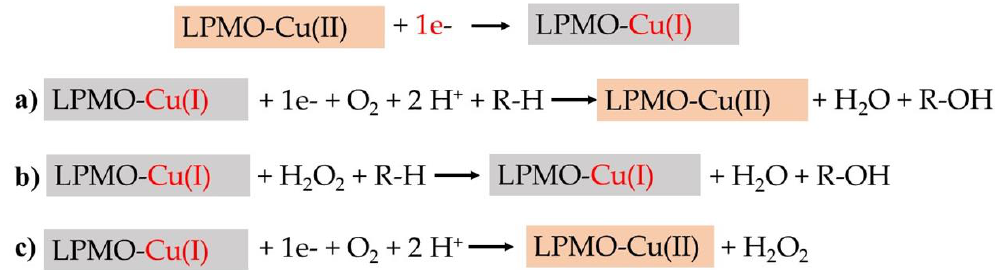
Figure 6. LPMO reaction mechanism. The first step is the reduction of the Cu(II) in the catalytic center by one electron to generate an LPMO-Cu(I) species. In the presence of a substrate (R-H), LPMO can react either with ( a ) O 2 or ( b ) H 2 O 2 , leading to substrate hydroxylation (R-OH). In the absence of a substrate ( c ), oxygen reduction by LPMO results in the generation of H 2 O 2 .